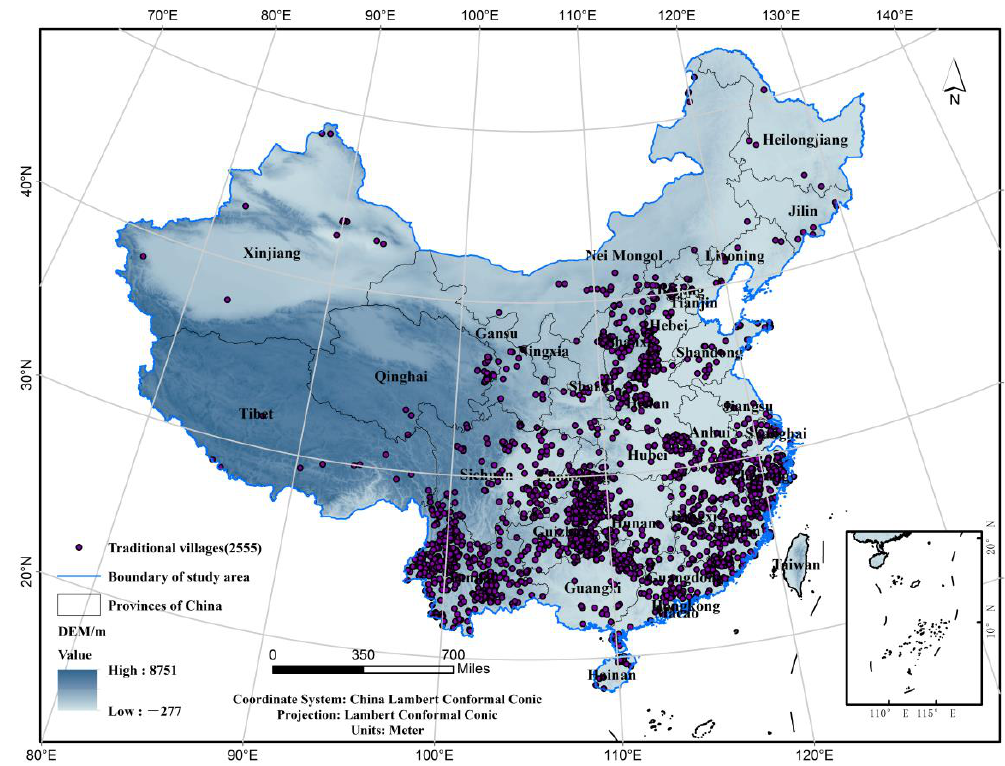
Figure 2. Geographical locations of the CTSs across